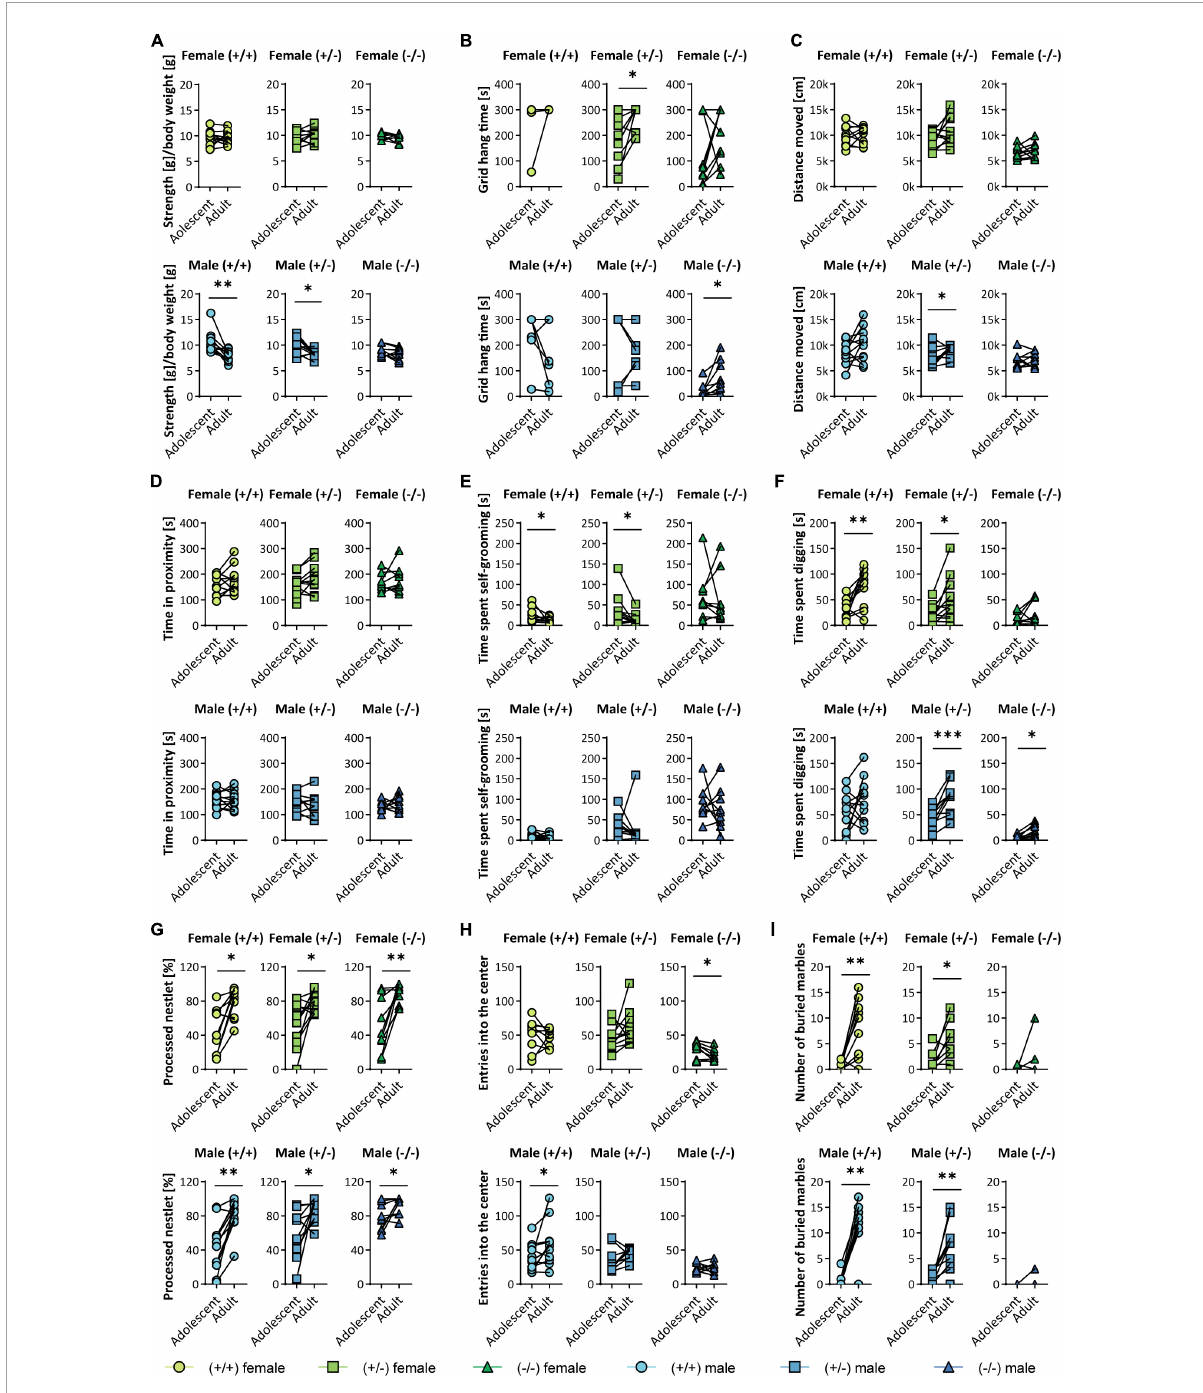
FIGURE4 Trajectory analysis of individual animals between baseline (adolescent) and follow-up (adult) Shank3 (+/–). A selected set of tests is analyzed longitudinally and displayed as follows: female (upper panels) and male (lower panels), wildtype (left), Shank3 ( ± ) (middle), and Shank3 (–/–) (right) mice. Graphs are displayed for (A) the normalized strength [strength/body weight] in the grip strength test for all four paws, (B) grid hang time in the grid hanging test, (C) the distance moved in the open field test, (D) the time the testing mouse spent in proximity ( < 3.5 cm) to a same-sex stranger in the direct social dyadic test, (E) the time the animal spent self-grooming and (F) digging, (G) the percentage of processed material in the nestlet shredding test, (H) the number of entries into the center zone of the open field arena during a 30 min trial, and (I) the number of buried marbles in the marble burying test. Data are presented for each individual animal at baseline and follow-up and was analyzed by paired two-tailed t -test for parametric data and by Wilcoxon matched pairs signed rank test for non-parametric data. Significance levels ( p -values) are set to 0.05 ( p ≤ 0.05 ∗ , p ≤ 0.01 ∗∗ , p ≤ 0.001 ∗∗∗ ) with 95% confidence interval. Detailed statistical information for all data sets can be found in Supplementary Table 5